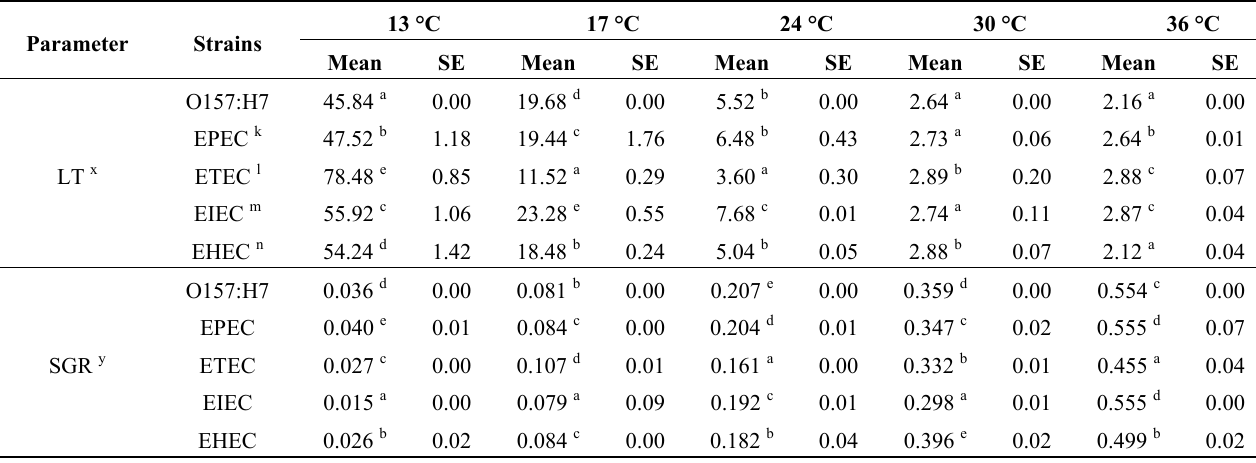
Table 2. Comparison of growth kinetics * for E. coli O157:H7 to those ** for various pathogenic E. coli strains in perilla